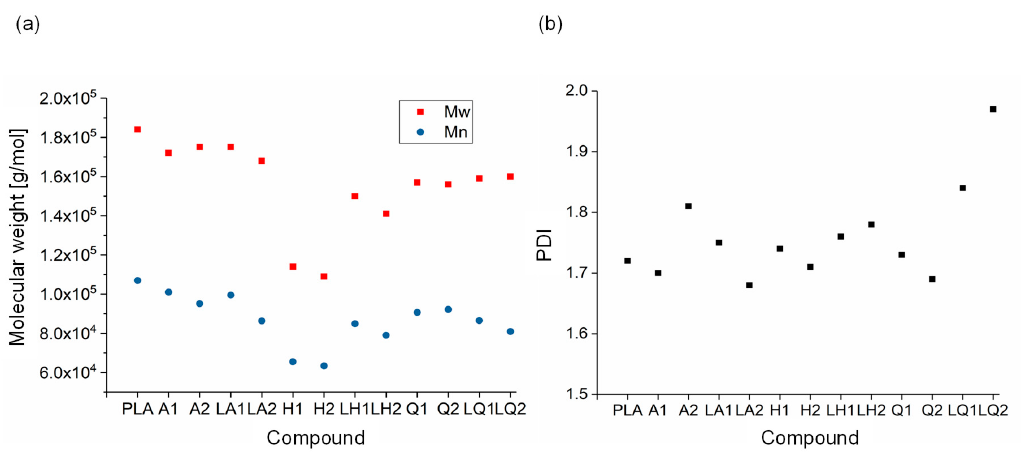
Figure 10. Molecular weight ( a ) and PDI ( b ) of PLA and the PLA/dye